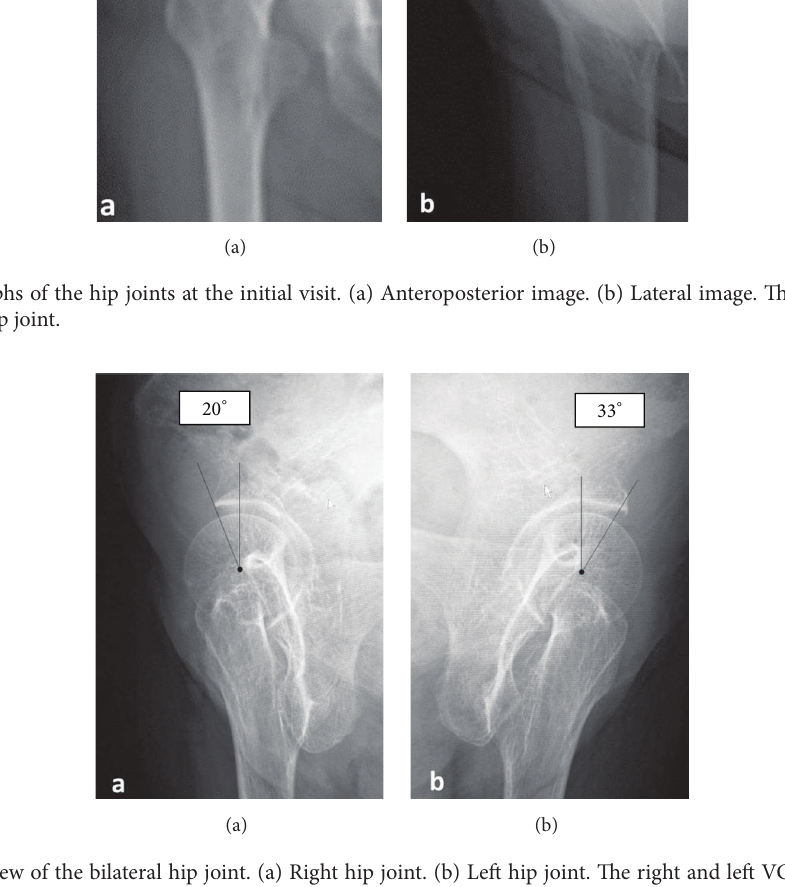
Figure 2: False-profile view of the bilateral hip joint. (a) Right hip joint. (b) Left hip joint. The right and left VCA angles are 20 ∘ and 33 ∘ , respectively. These findings reveal developmental dysplasia of the right hip joint.